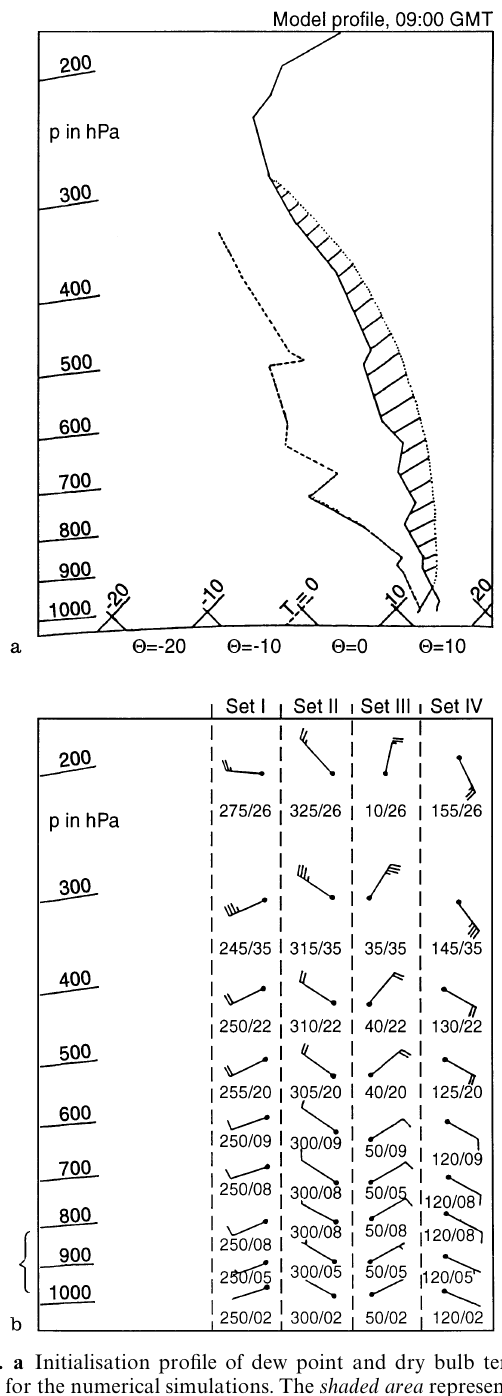
Fig. 3. a Initialisation profile of dew point and dry bulb temper- atures for the numerical simulations. The shaded area represents the convectively available potential energy (CAPE) of the air masses. b Profiles of wind vectors given in degrees and knots